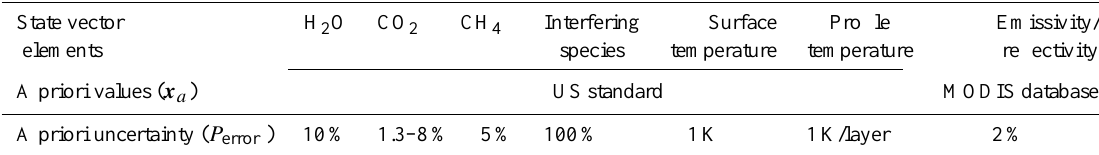
Table 2. State vector parameters. State vector H 2 O CO 2 CH 4 Interfering Surface Profile Emissivity/ elements species temperature temperature reflectivity A priori values ( x a ) US standard MODIS database A priori uncertainty ( P error